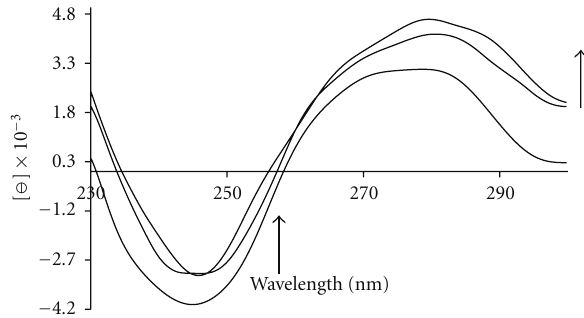
Figure 2: Absorption spectra of (a) DNA (5 × 10 − 5 M) in the absence (strong line) and presence of increasing amounts of Pt complex: r i = [Complex]/[DNA] = 0.0, 0.1, 0.3, 0.5, 0.7.